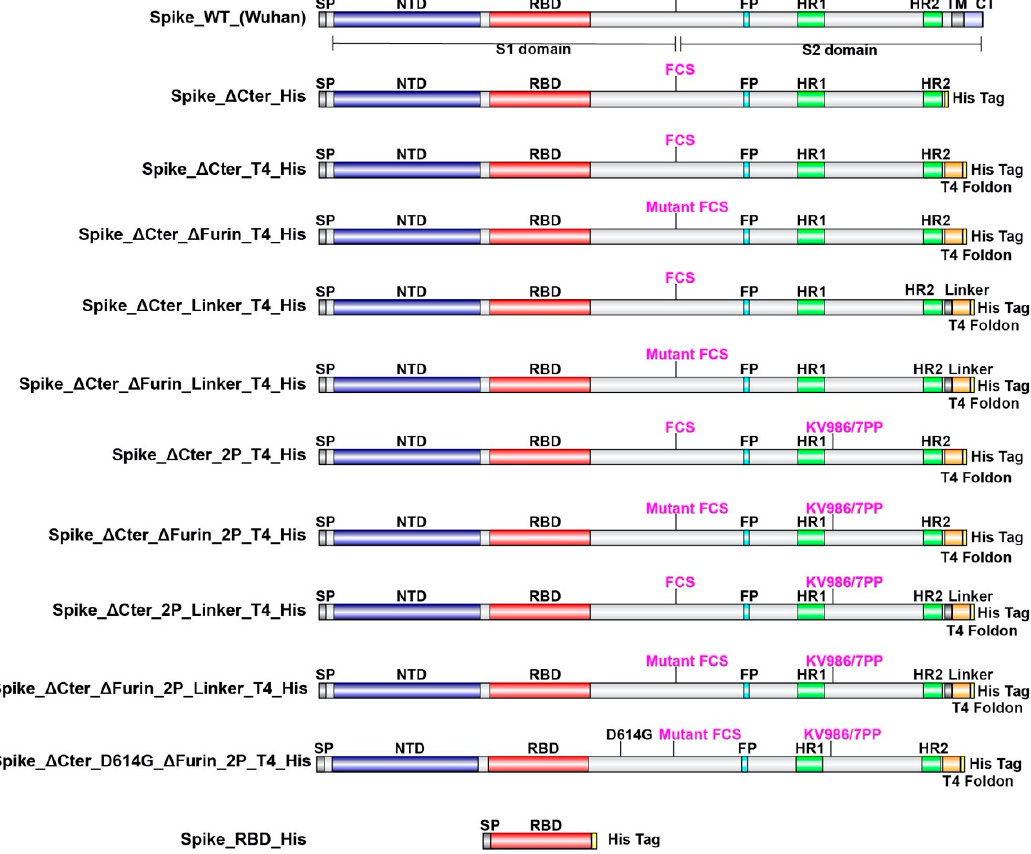
Figure 1. Schematic representation of SARS-CoV-2 spike protein designs. SP: Signal Peptide, NTD: N Terminal Domain, RBD: Receptor Binding Domain, FCS: Furin Cleavage Site, FP: Fusion Peptide, HR1: Heptad Repeat 1, HR2: Heptad Repeat 2, TM: Transmembrane Domain, CT: C terminal Tail.